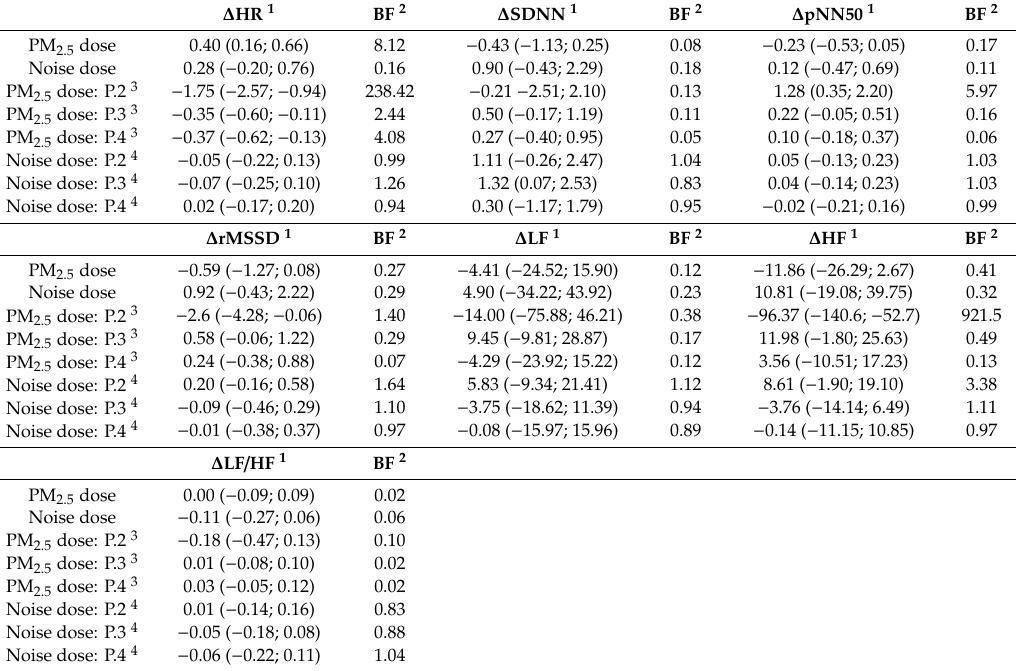
Table 7. E ff ects of total inhaled doses of PM 2.5 and total noise dose exposure levels on ECG parameters variability 1